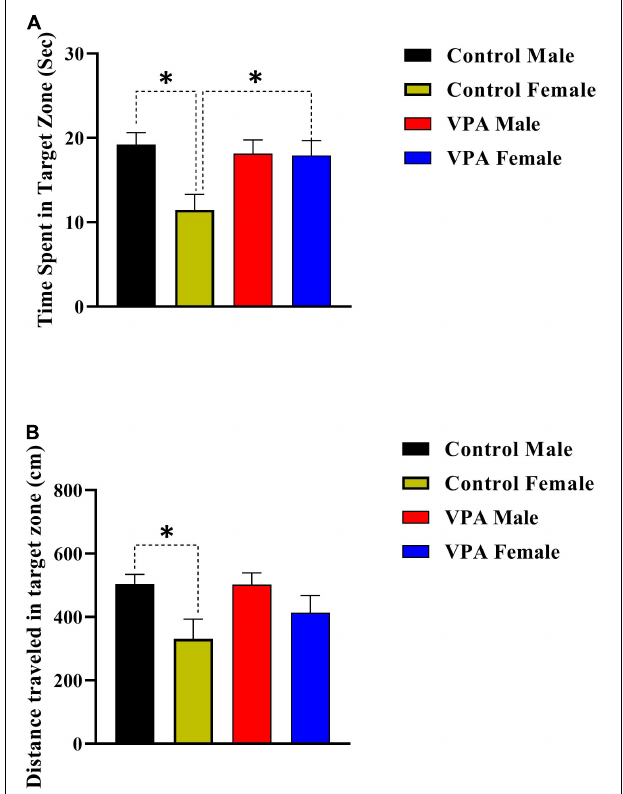
FIGURE 4 | Probe trial performance of male and female rats. There was significant gender difference between male and female control rats but not for VPA-exposed male and female offspring for time spent time (A) and traveled distance (B) in the target zone. Data are presented as mean ± SEM. ∗ p <